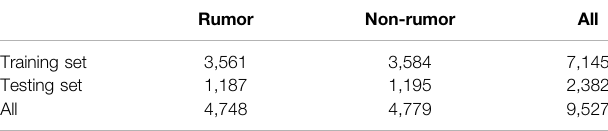
TABLE 1 | Statistics of the